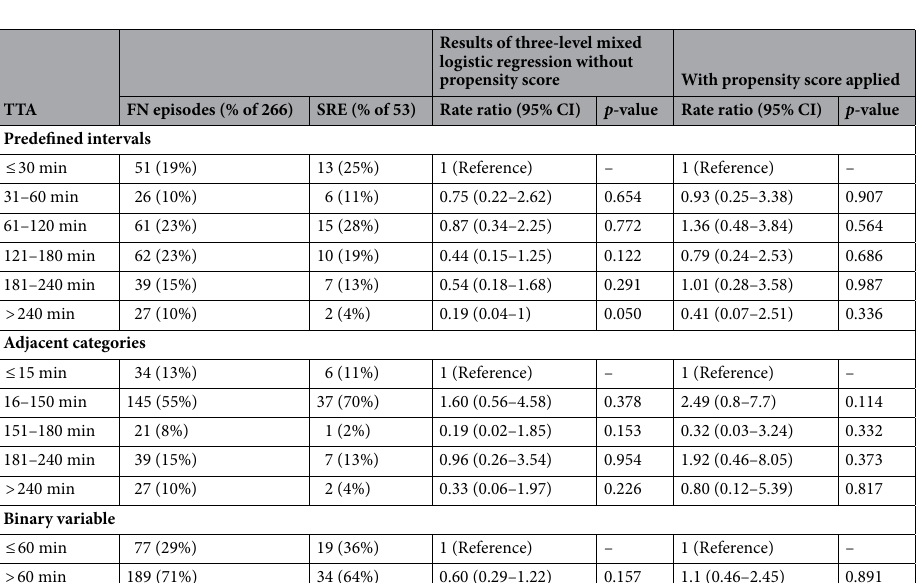
Table 1. Association between time from fever to start of antibiotics (TTA) and the occurrence of safety relevant events (SRE). CI confidence interval, FN fever in neutropenia, TTA time from fever to start of antibiotics, SRE safety relevant event.